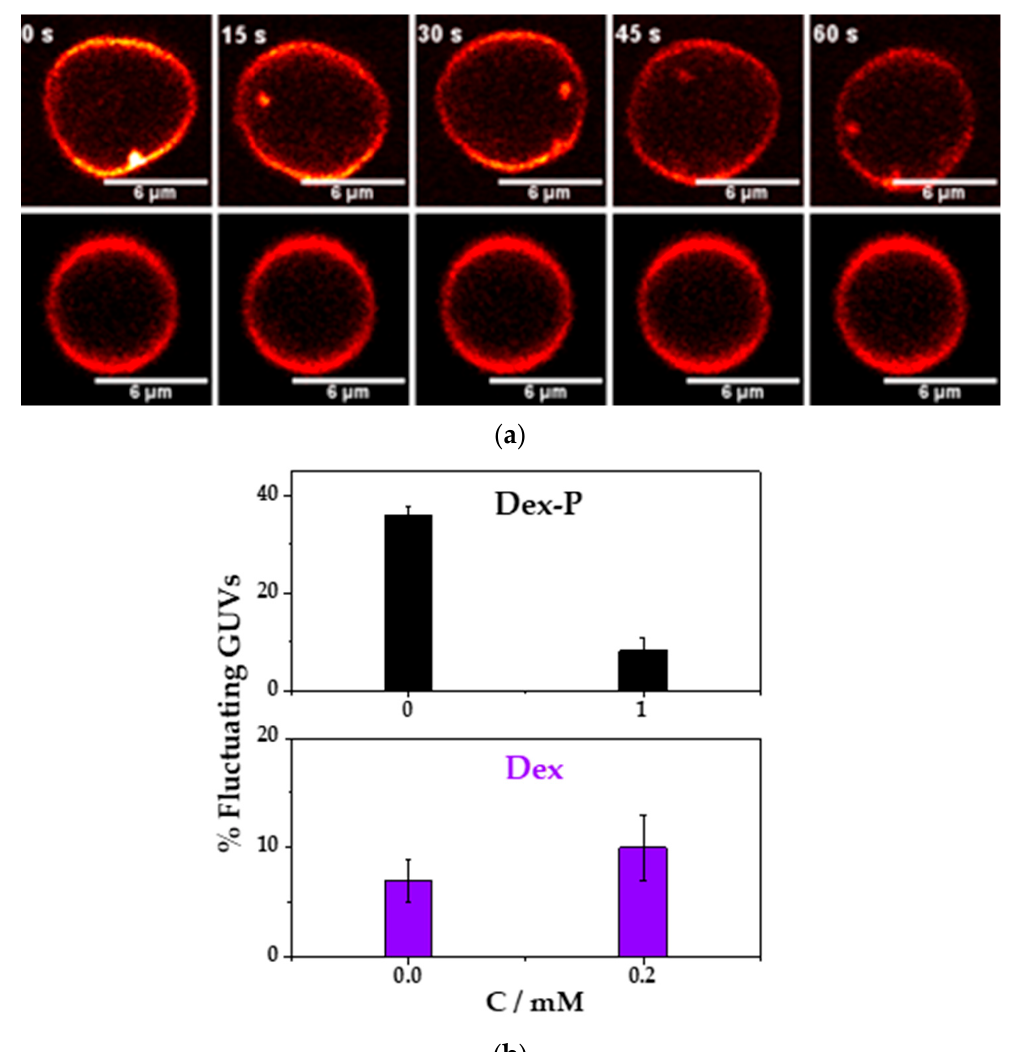
Figure 7. ( a ) Representative snapshots of GUVs composed of pure DMPC: fluctuating vesicle (upper panel) and a non-fluctuating vesicle (lower panel) as function of the time. ( b ) Percentage of fluctuating vesicles as a function of drug concentration for Dex-P (upper panel, black) and Dex (lower panel,